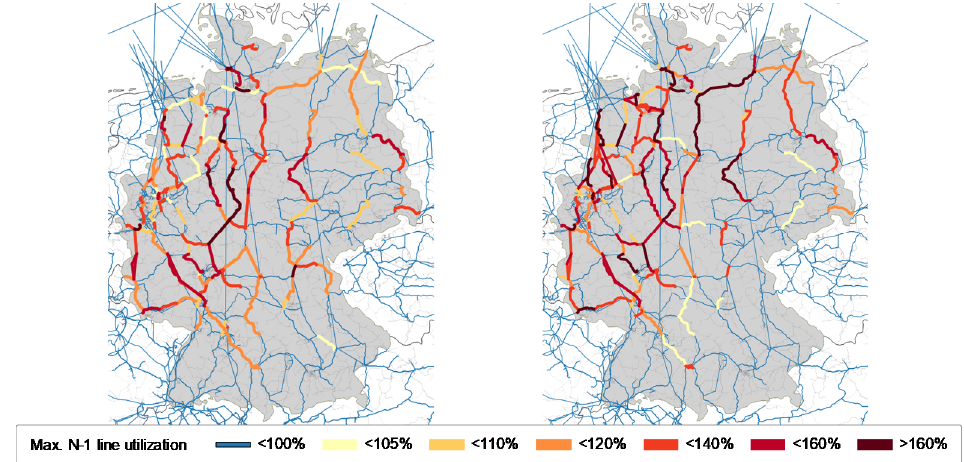
Figure 17. The maximum line utilization in case of N-1 equipment outages: ( left ) picture shows reference scenario 2035, and ( right ) picture shows the sensitivity with increased offshore wind.